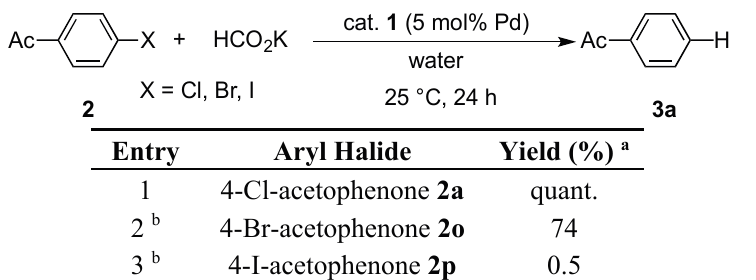
Table 3. Hydrodehalogenation of acetophenone-4-halide with ammonium formate in